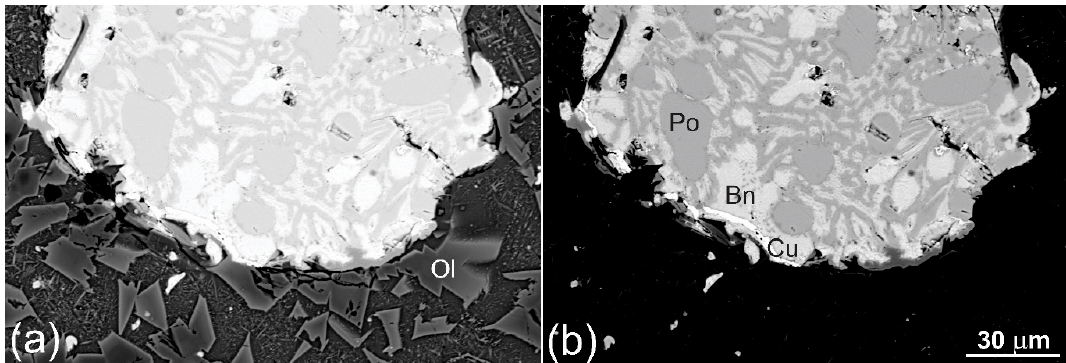
Figure 5. SEM-EDS maps displaying the elemental abundance in a small area highlighted in Figure 4b. First image is SEM-BSE. Areas rich in Al, Ca and Si correspond to the amorphous matrix. High brightness in Cu is elemental copper.